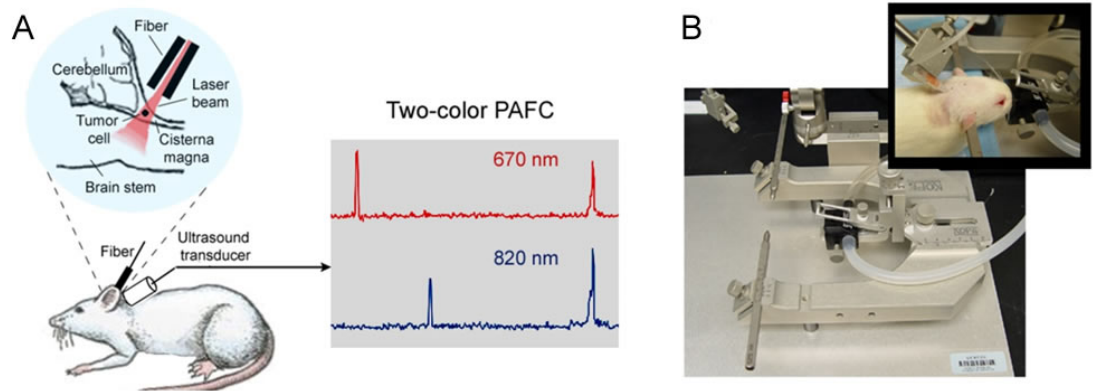
Figure 23. Integrated technical platform for testing CSF in vivo and ex vivo . ( A ) Schematic of multicolor PAFC with the example of real-time two-color PAFC tracings from CSF; ( B ) The heating stereotaxic table for in vivo PAFC and CSF sampling.